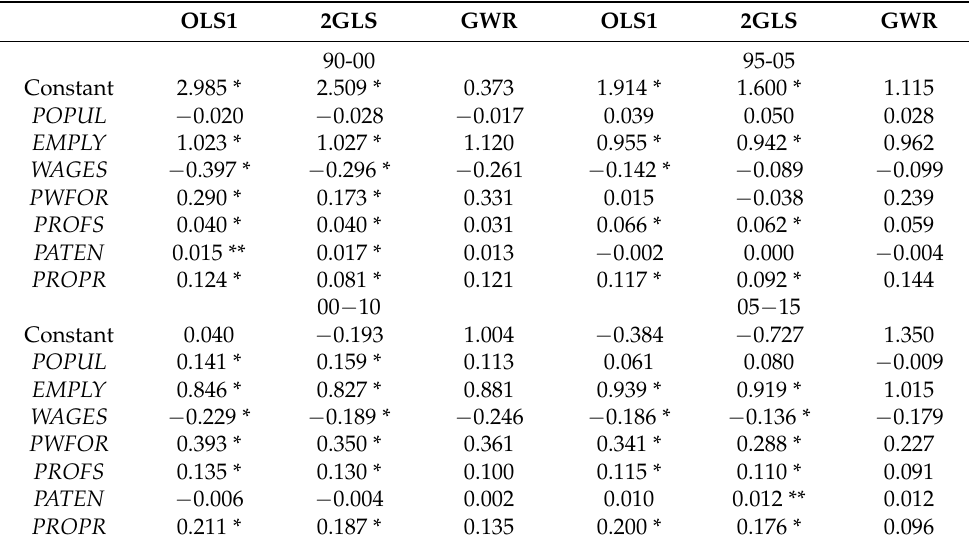
Table 2. Reduced-Form Employment Estimates: 10 Year